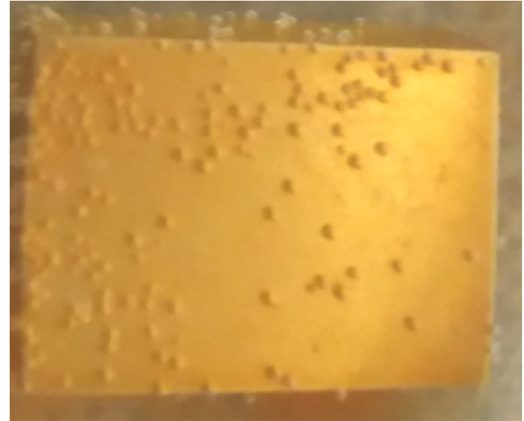
Figure 4. AZ91D alloy during cerium conversion coating bath with hydrogen evolution. H evolution during metal/coating interface anodic and 2 cathodic reactions. When blisters evolution is more severe some cracks and exfoliation may appear in the top surface. Blisters are mainly formed around α-Mg phase because of the electrochemical potential difference between this phase and the Al-rich β -phase on the AZ91D alloy. Blisters pressure